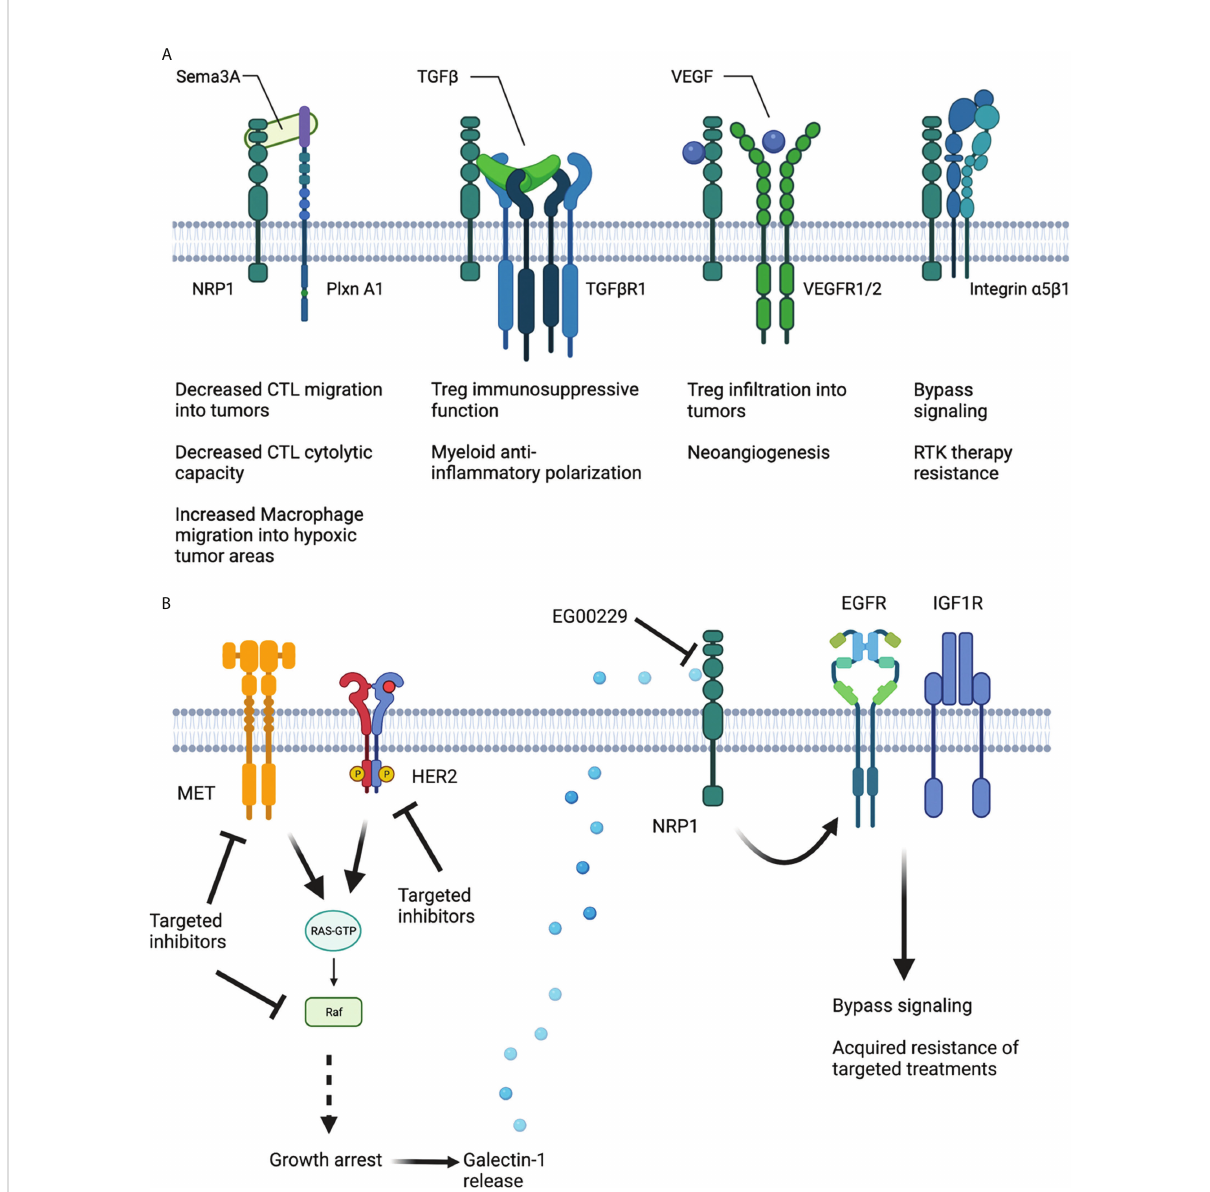
FIGURE 1 Schematic of NRP1 structure and interaction with various co-receptors to modulate immune cell function and targeted treatment resistance. (A) Sema3A hinders cytotoxic T cell migration into tumors and their cytolytic capability. SEMA2a also encourages macrophage migration into hypoxic tumor areas to resolve hypoxia and accelerate tumor progression. TGF b augments Treg immunosuppressive function and myeloid anti- in fl ammatory polarization in a NRP1-dependent fashion. VEGF, binding to NRP1 and VEGFR1/2 increases Treg in fi ltration into tumors and promotes neoangiogenesis. NRP1 along with Integrin a 5 b 1 encourages bypass signaling to support adaptive resistance to RTK therapies. (B) Therapies designed to inhibit MET, Her2 and BRAF signaling in tumor cells result in Galectin-1 release in a manner amenable to NRP1 b1 domain inhibition. Ligation of Galectin-1 to NRP1 results in EGFR and IGF1R activation and subsequent bypass signaling and acquired adaptive treatment resistance. Created using